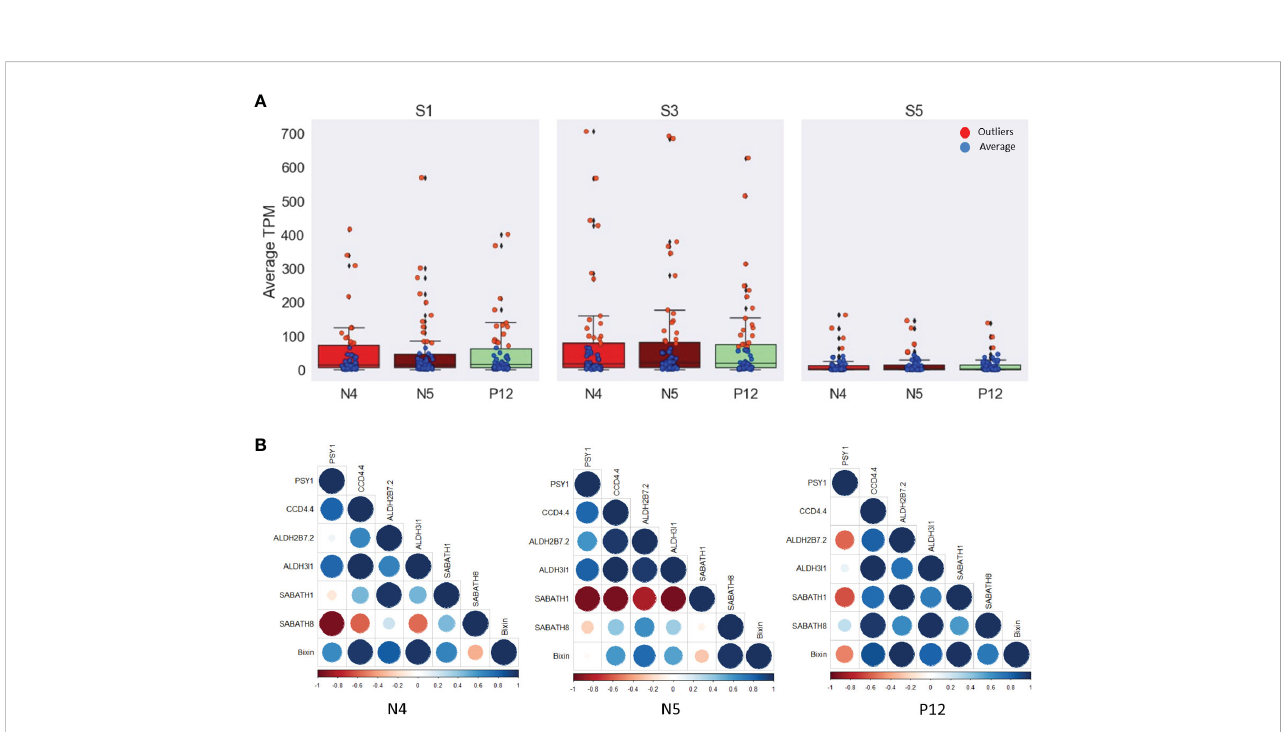
FIGURE 5 TPM analysis of the 57 genes related to isoprene, terpene, carotene, and carotenoid pathways. (A) Box plots showing the average (blue) and outlier (red) genes during the seed development. S3 exhibits most of the outlier genes. (B) Heat maps showing the spearman correlation among the more highly correlated genes with the bixin in each B . orellana accession. The low correlated PSY1 gene was selected to show the differences in the correlation values. The head arrow indicates the bixin. Bo nomenclature from gene names was removed to simplify the